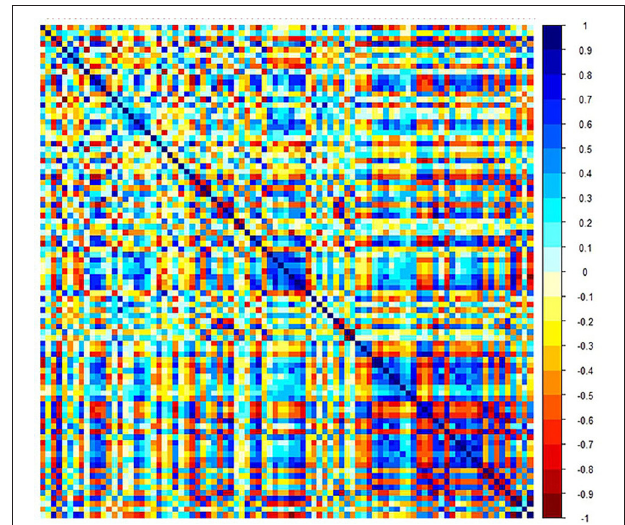
FIGURE 1 | Graph shows correlation analysis between the parameters of training data.